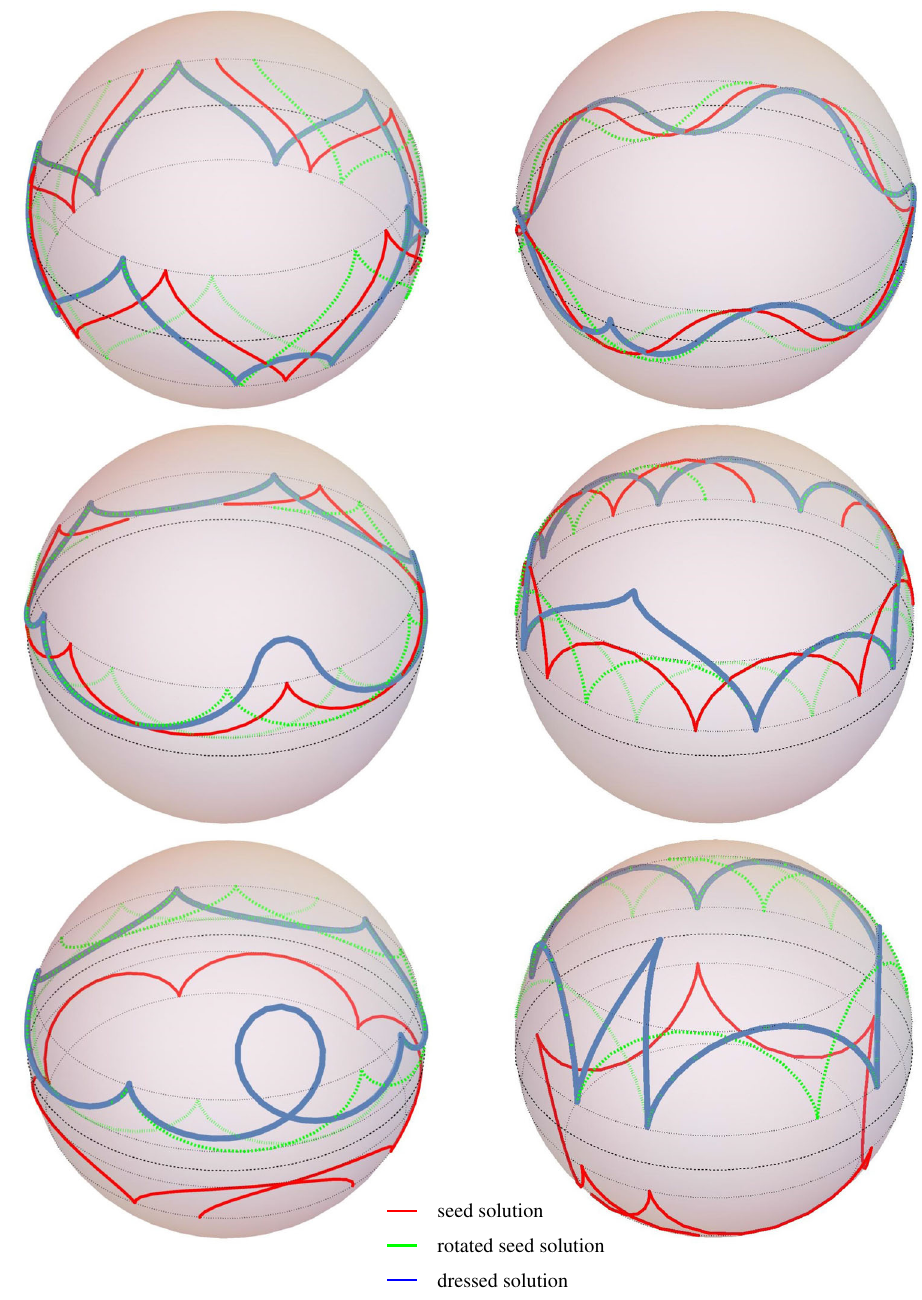
Fig. 12 The finite dressed string solutions with approximate periodicity conditions and n 2 = 1. The left and right column solutions have seeds with translationally invariant and static Pohlmeyer counterparts, respectively. On the first row the seed solution has an oscillating counterpart with E = μ 2 / 10 and a selected so that n 1 = 10. On the second and third rows the seed solution has a rotating counterpart with E = 6 μ 2 / 5 and a selected so that n 1 = 7. On the first and second rows θ 1 = π/ 12, whereas on the third row θ = 7 π/ 8. The solutions of the 1 second and third row belong to the θ 1 < ˜ θ − and θ 1 > ˜ θ + classes of solutions,